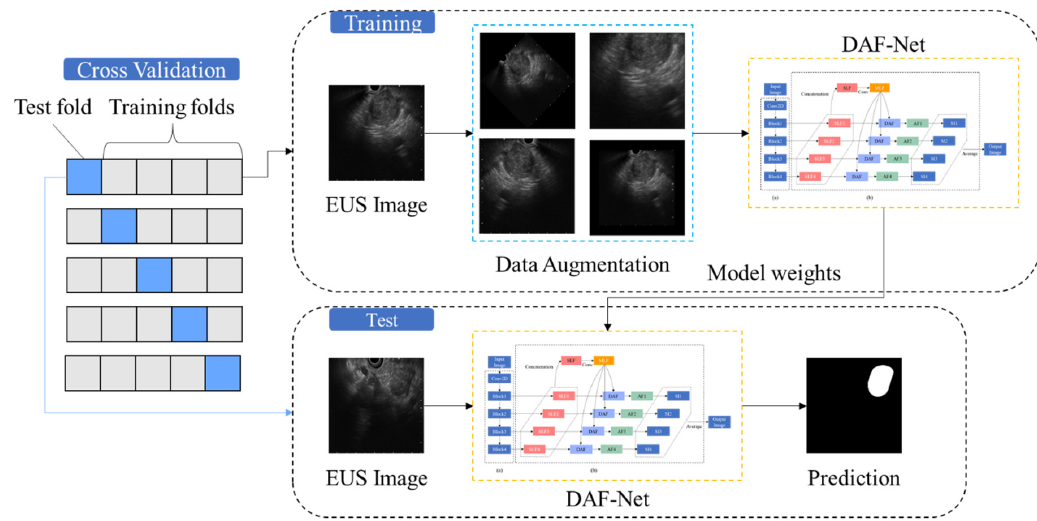
Figure 1. Overall flowchart of the proposed deep learning approach.